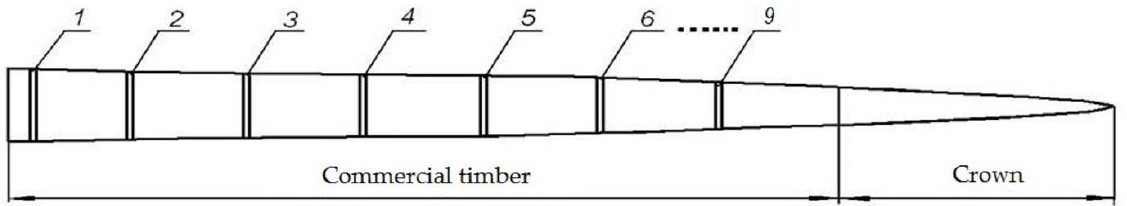
Figure 1. The scheme of cutting sections from the tree trunk: 9 cuts of wood cut from the trunk at 1 m intervals.